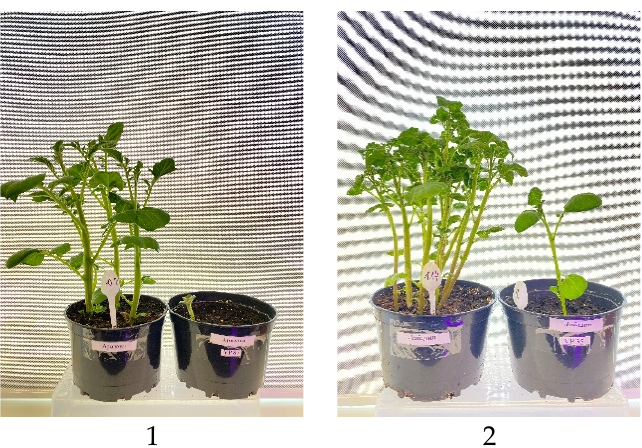
Figure 9. Potato plants 30 days after planting with a healthy tuber ( left ) and tubers from PSTVd infected plants ( right ): 1—cv. Arizona, strain PSTVd VP87; 2—cv. Labadia, strain VP35.